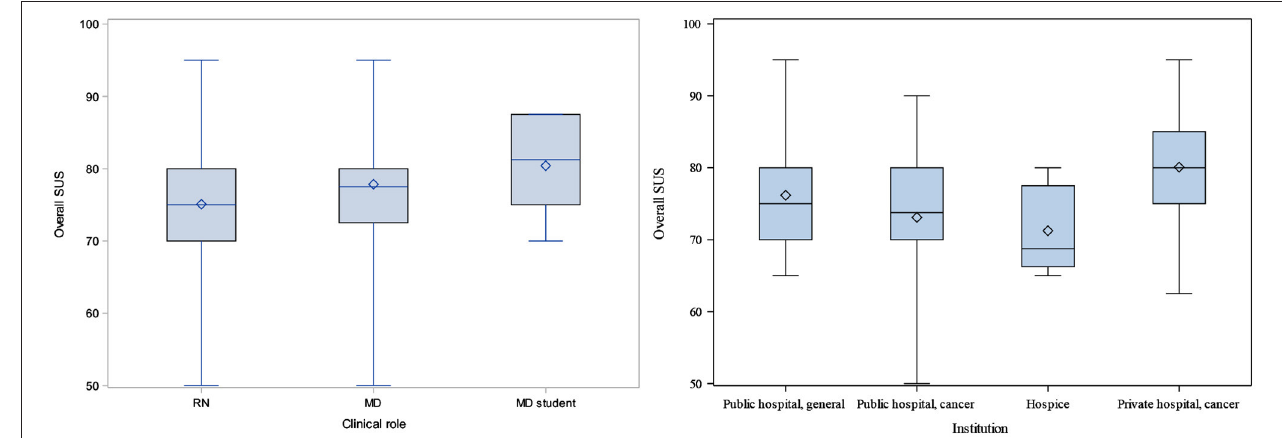
FIGURE 4 | Overall SUS scores by clinical role (left) and institution (right).